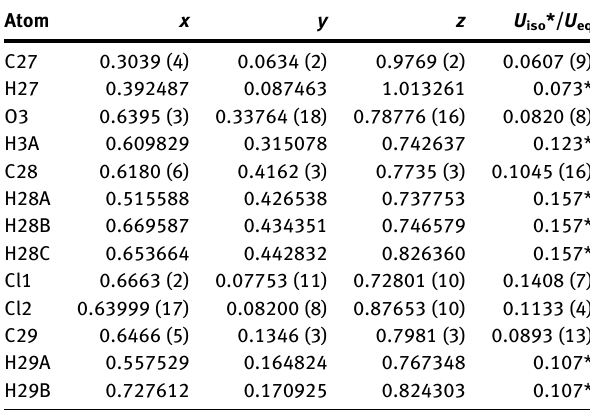
Table  : Fractional atomic coordinates and isotropic or equivalent isotropic displacement parameters (Å 